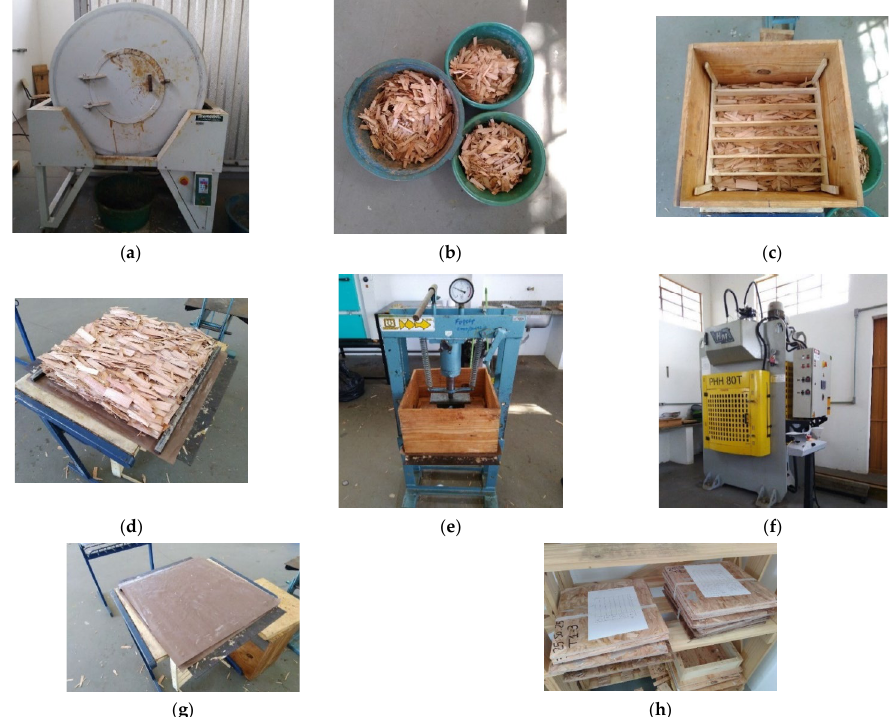
Figure 2. OSB manufacturing: ( a ) gluing, ( b ) strands already with adhesive, ( c ) particle router, ( d ) particle mattress, ( e ) cold pressing, ( f ) hot pressing, ( g ) post hot-pressing panel and ( h ) finished panels.